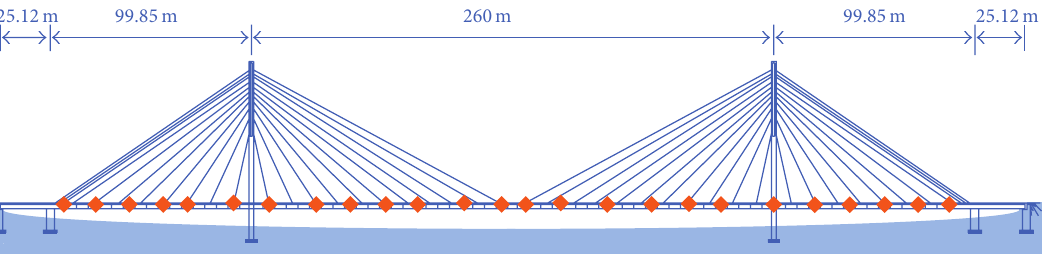
Figure 8: The optimal sensor configuration extracted by SDFA with the MAC.